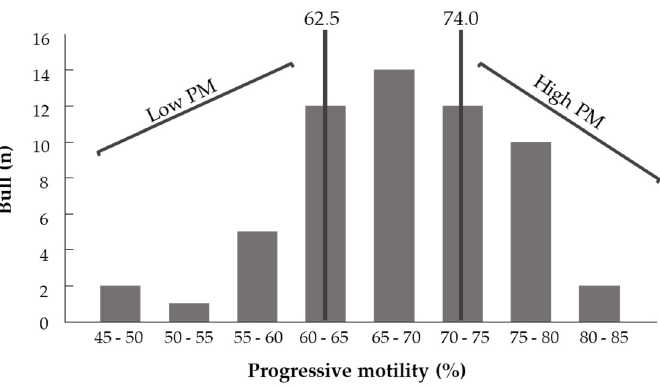
Figure 2. Distribution of bulls according to the proportion of progressively motile spermatozoa. Ejaculates with values higher than 74.0% (25% of the bull population with the highest PM) were defined as high PM and ejaculates with values lower than 62.5% (25% of the bull population with the lowest PM) were defined as low